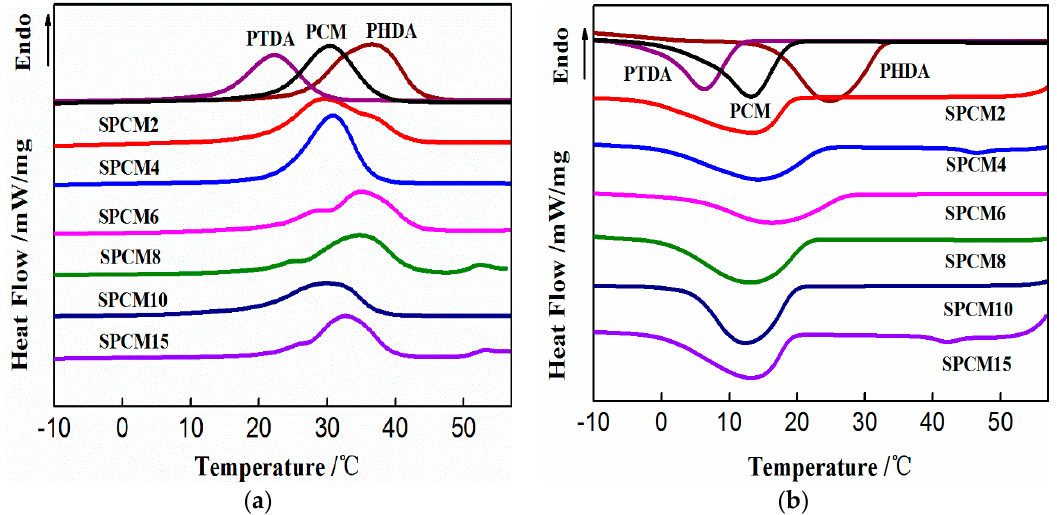
Figure 5. Curves of poly(tetradecyl acrylate) (PTDA), poly(hexadecyl acrylate) (PHDA), P(TDA- co -HDA), and the SPCMs during the ( a ) heating and ( b ) cooling processes. Table 1. Phase change properties of poly(tetradecyl acrylate) (PTDA), poly(hexadecyl acrylate) (PHDA), phase change materials (SPCMs) from the differential scanning calorimetry (DSC) analysis *.